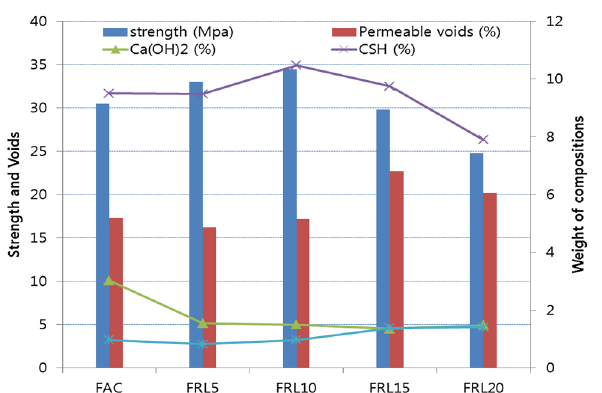
Fig. 11 Results of composition weight with strength and